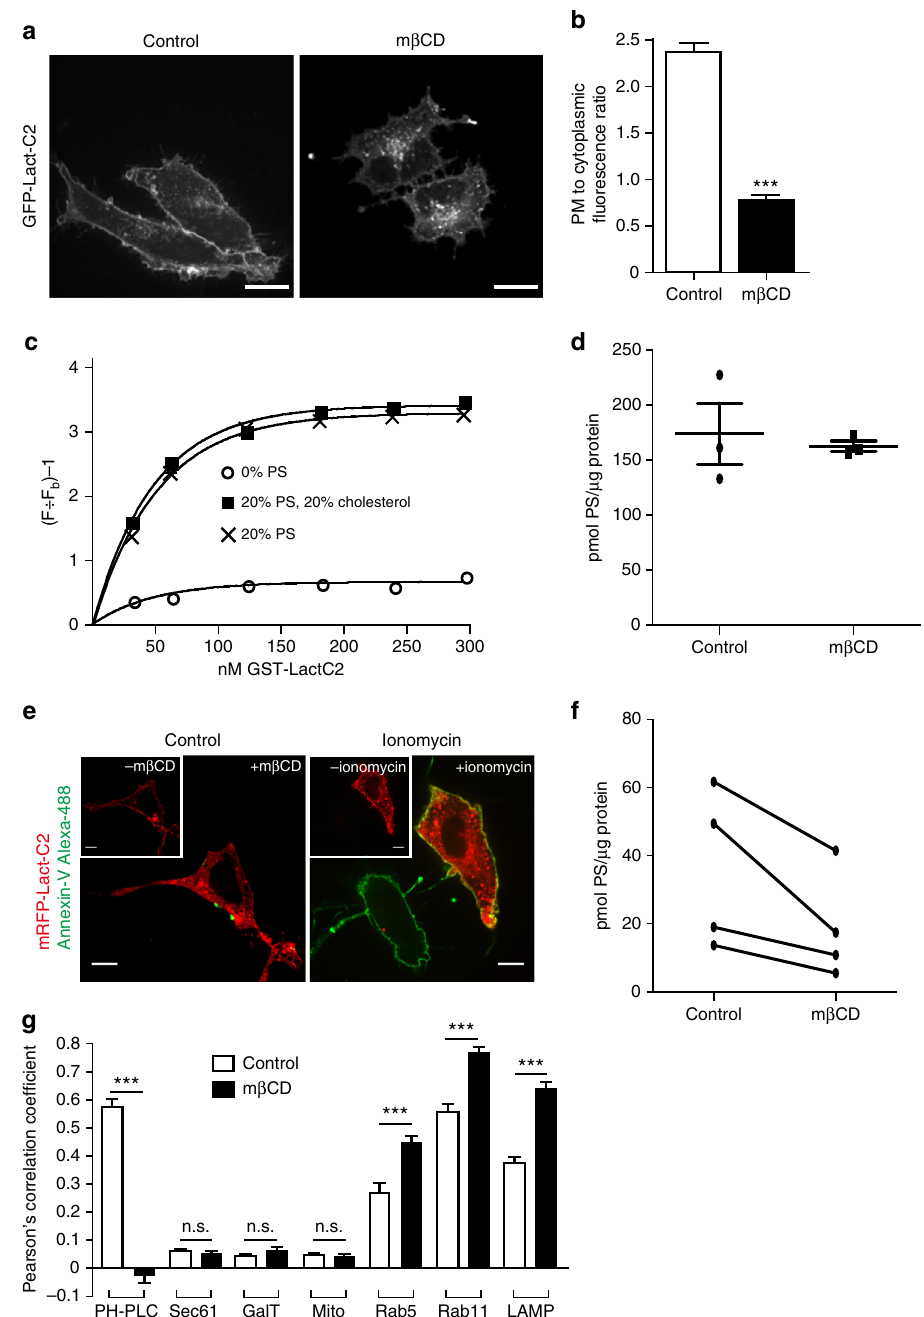
Fig. 1 PtdSer is redistributed upon cholesterol extraction. a Distribution of GFP-LactC2 in HeLa cells that were untreated or treated with 10 mM m β CD for 30 min. Images in A are representative of at least 4 experiments of each type. b Quantitation of the ratio of PM to cytoplasmic GFP-LactC2 from A, n = 40 cells. c Quantitation of GST-LactC2 to liposomes containing egg-PtdCho, dansyl-PtdEtn, 0% or 20% PtdSer, with 0% or 20% cholesterol. The term (F ÷ Fb) − 1 refers to the observed FRET resulting from the proximity of dansyl-PtdEtn in the liposome to tryptophan residues in GST-LactC2. d Comparison of the total PtdSer content of control and m β CD-extracted cells. PtdSer extracted from cells was reacted with fl uorescamine and quanti fi ed by measuring fl uorescence intensity after separation by TLC, then normalized to total protein of the cells.Data are means ± s.e.m from three separate experiments. e HeLa cells expressing mRFP-LactC2 (red) were treated with either 10 mM m β CD (left) or 10 μ M ionomycin (right) for 10 min and subsequently incubated with Alexa-488-labeled Annexin V (green) to visualize exofacial PtdSer. Insets: pre-treatment images for each. f Comparison of the PtdSer content of plasma membranes isolated from control and m β CD-treated cells using polycationic beads. Plasma membranes were isolated as described in Supplementary Fig.1, and PtdSer quanti fi ed as in D. Data are means ± s.e.m of 4 separate experiments. g Subcellular distribution of PtdSer in control (black bars) and m β CD-extracted cells (open bars), determined by the colocalization using Pearson ’ s correlation coef fi cient of the GFP-LactC2 probe with the following organellar markers: PH-PLC δ , (PM marker); Sec61, (endoplasmic reticulum marker); GalT, (Golgi complex); MitoTracker, (mitochondria); Rab5, Rab11 and LAMP1, used as markers of early endosomes, recycling endosomes and late endosomes/lysosomes, respectively. Data represent the means ± s. e.m of for 35 independent cells collected from three separate days. NS = not signi fi cantly different, * p < 0.05, ** p < 0.01 and *** p < 0.005; as determined using a two-tailed t-test. The same test and designation of p-value is used throughout the remaining fi gures. Scale bar = 10 µ m in all images NATURE COMMUNICATIONS | 8: